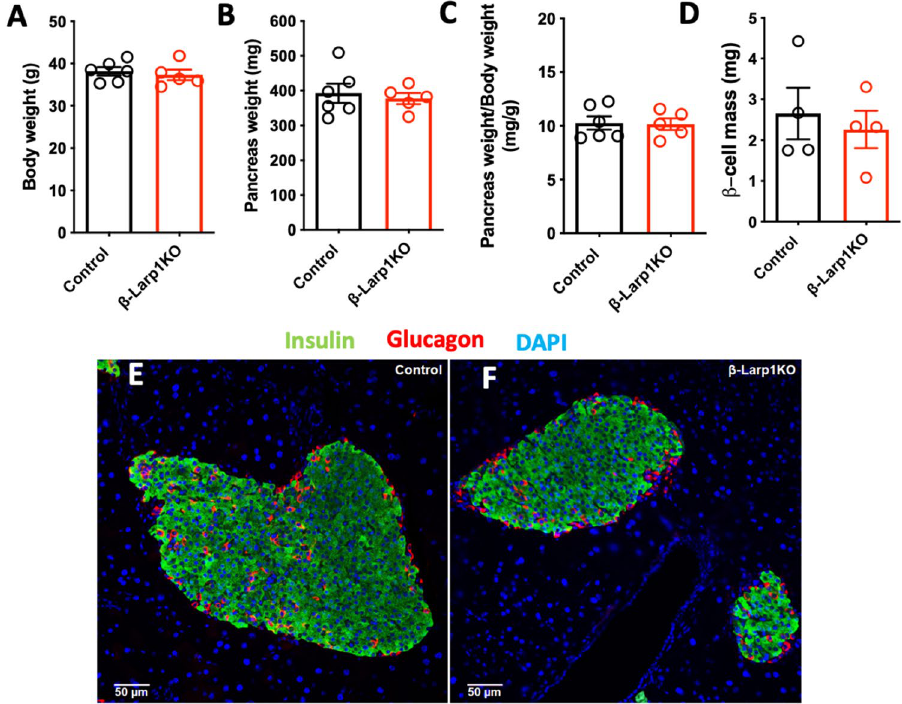
Figure 9. Morphology assessment of β-Larp1KO mice under high branched-chain amino acid diet (BCAA). ( A ) Body weight, ( B ) pancreas absolute weight, ( C ) pancreas weight relative to body weight and ( D ) β-cell mass of mice fed with high branched-chain amino acid diet (150% BCAA) for 17 weeks. ( E , F ) Representative images of islets in the control and β-Larp1KO mice,